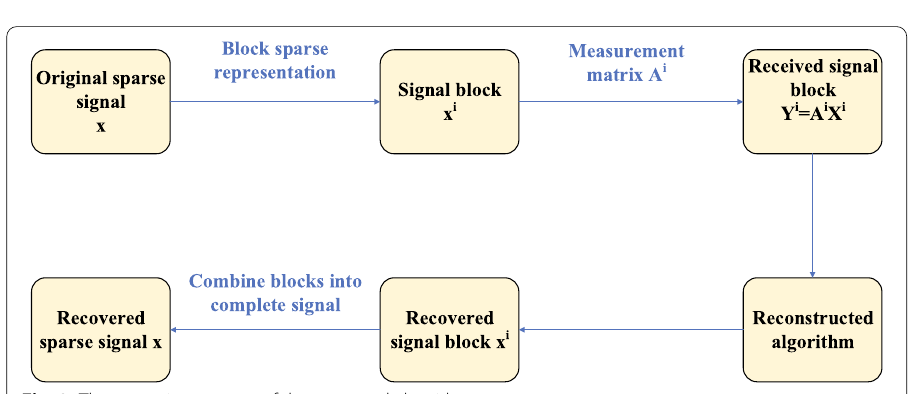
Fig. 2 The execution process of the proposed